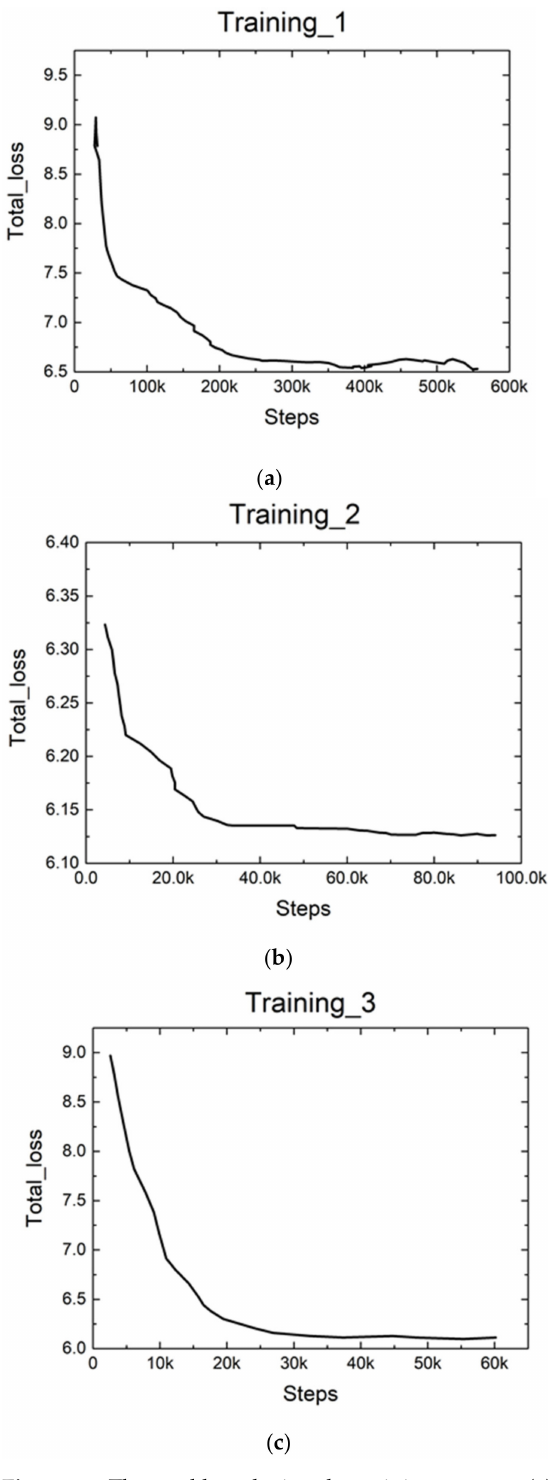
Figure 12. The total loss during the training process: ( a ) the total loss over the first training process; ( b ) the total loss over the second training process; ( c ) the total loss over the third training